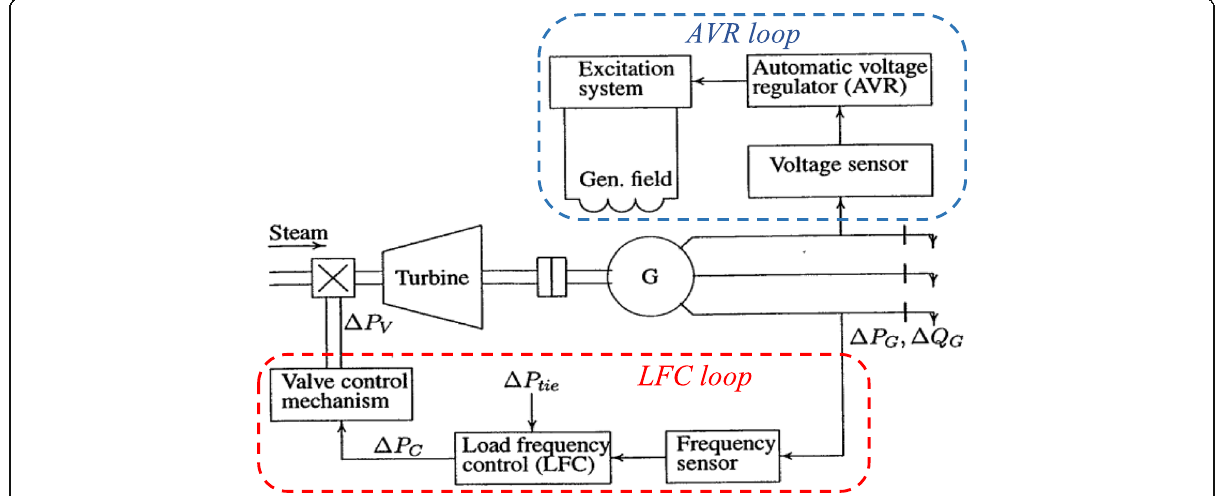
Fig. 1 Schematic diagram of LFC and AVR control loops